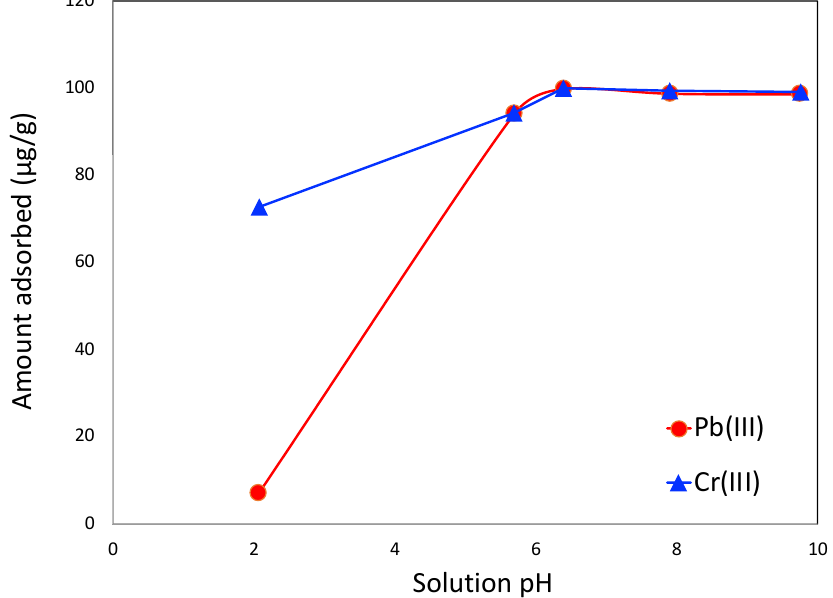
Figure 9. Influence of solution pH in the adsorption of Pb(II) and Cr (III) in mixture. The pH studies were performed in batch mode with a Pb(II) concentration of 100 ppb ( 𝜇 g/L) and the adsorbent concentration was 1 g/L.